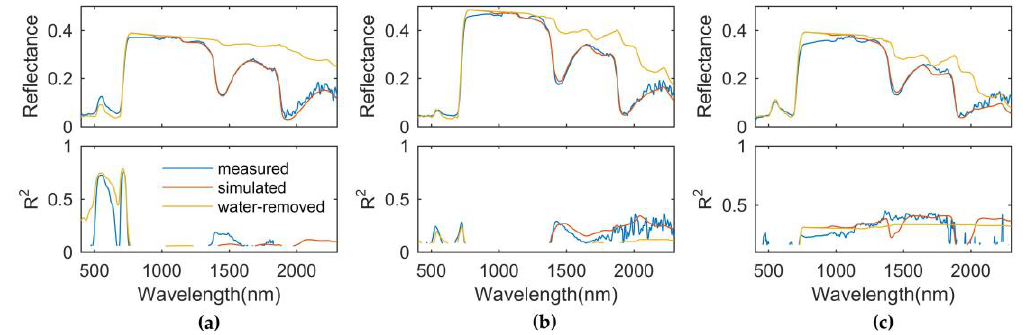
Figure 4. Comparisons on reflectance and their R 2 value with area-based LNC across three species. ( a ) Maize ( Zea mays L.); ( b ) Sawtooth Oak ( Quercus acutissima ); ( c ) Sweetgum ( Liquidambar formosana ). The legend of the spectra type is given in ( a ). Only R 2 values at the 0.01 significance level were presented.